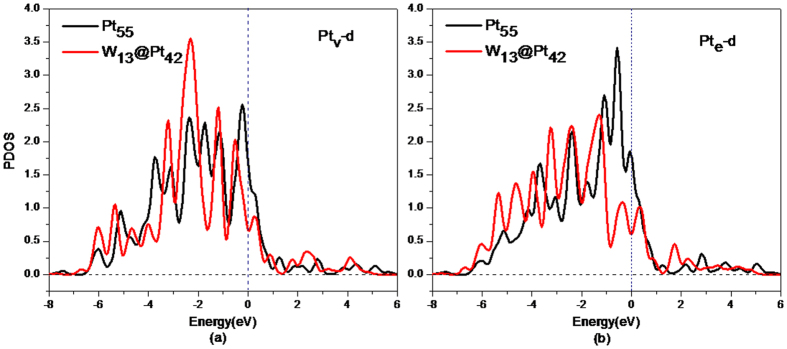
The partial electronic density of states of Pt atoms in Pt55 and W13@Pt42.